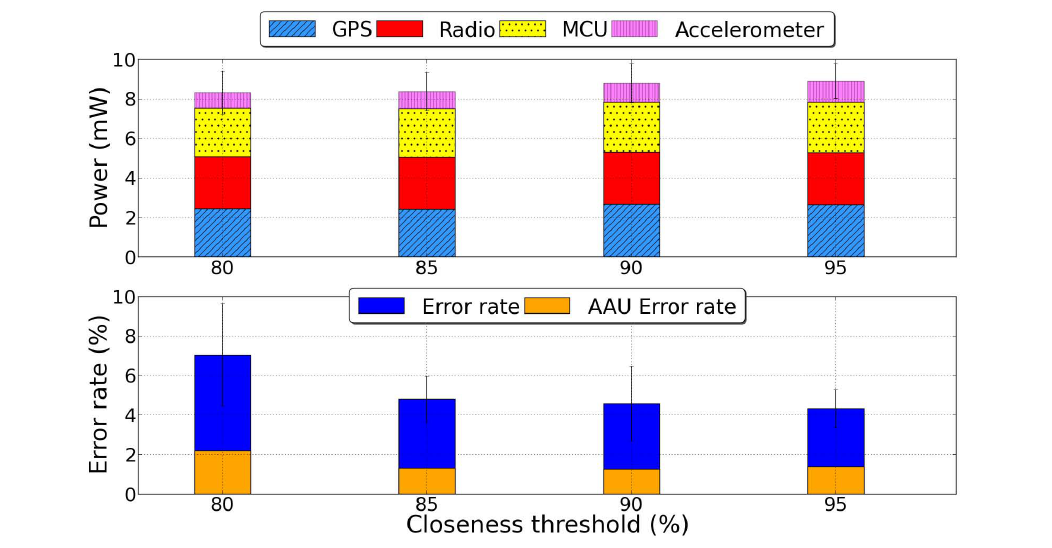
Figure 20. Performance with different proximity threshold